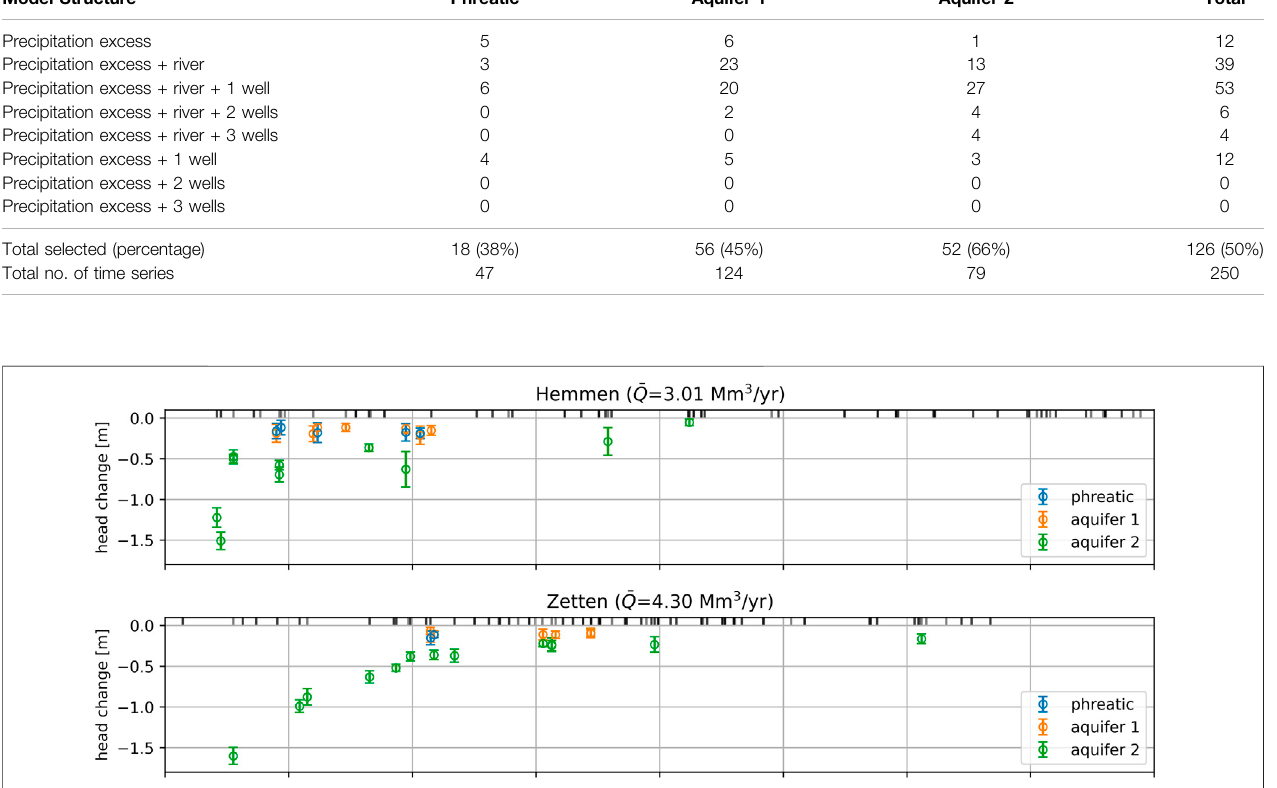
Frontiers in Earth Science |